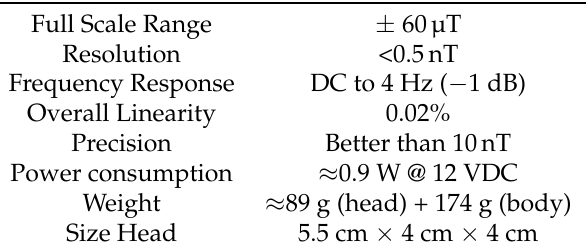
Table 1. Developed magnetometer specifications summary.